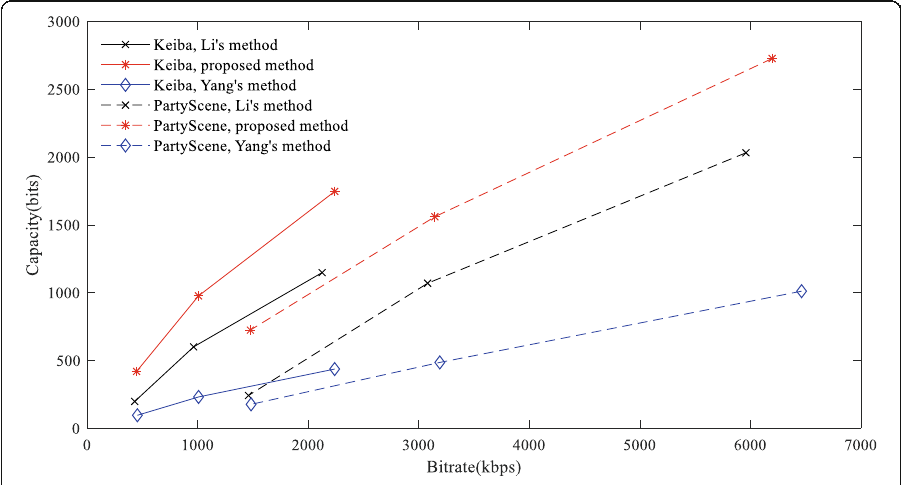
Fig. 8 Comparison of RC with Li ’ s method and Yang ’ s method for sequences Keiba and